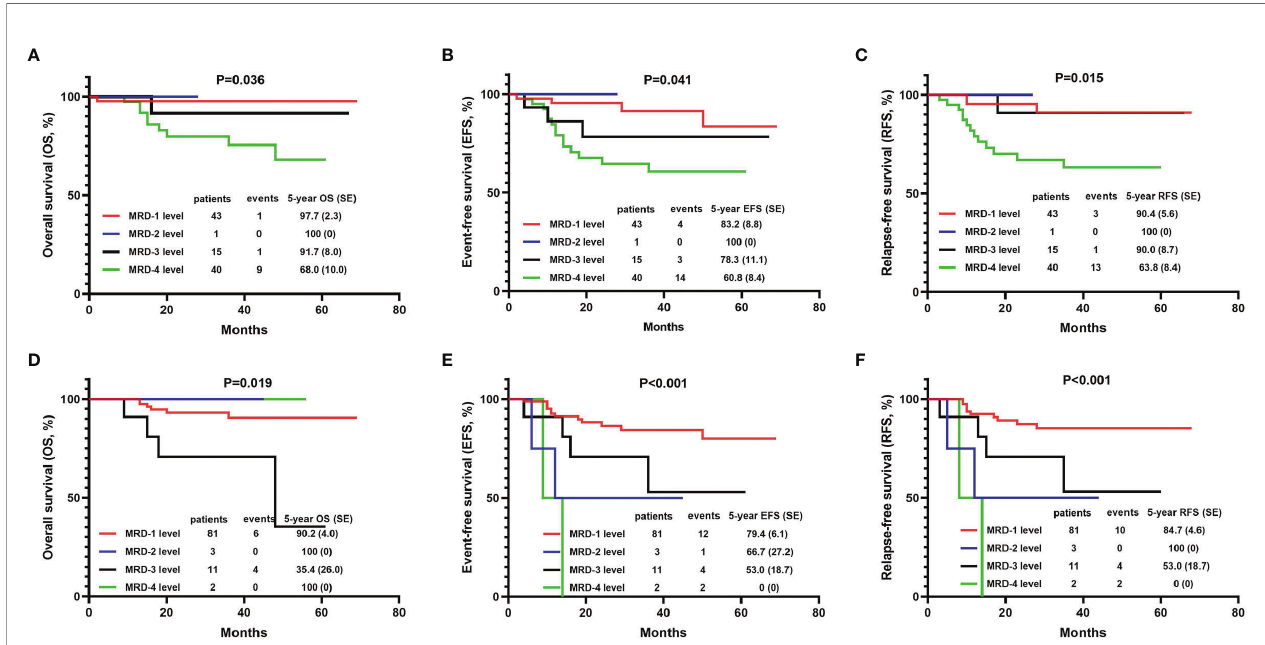
FIGURE 3 | The 5-year OS, EFS, and DFS of T-ALL children with different grades of minimal residual disease (MRD). (A) Comparison of 5-year OS with different MRD grades on the 19th day of induction therapy. (B) Comparison of 5-year EFS with different MRD grades on the 19th day of induction therapy. (C) Comparison of 5-year DFS with different MRD grades on the 19th day of induction therapy. (D) Comparison of 5-year OS with different MRD grades on the 46th day of induction therapy. (E) Comparison of 5-year EFS with different MRD grades on the 46th day of induction therapy. (F) Comparison of 5-year DFS with different MRD grades on the 46th day of induction therapy. MRD-1 level, MRD<10 -4 ; MRD-2 level, 10 -4 ≤ MRD<10 -3 ; MRD-3 level, 10 -3 ≤ MRD<10 -2 ; MRD-4 level, MRD ≥ 10 -2